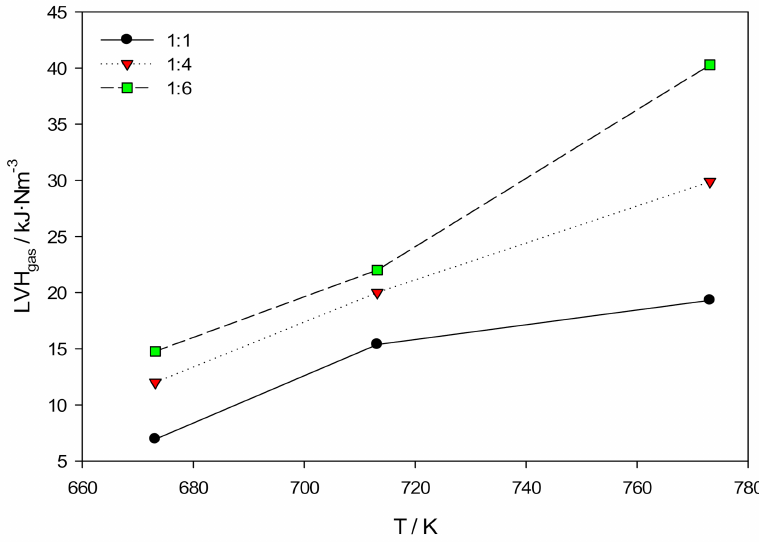
Figure 7. LHV of SCWG from guava fruit waste at different B:W mass ratios.